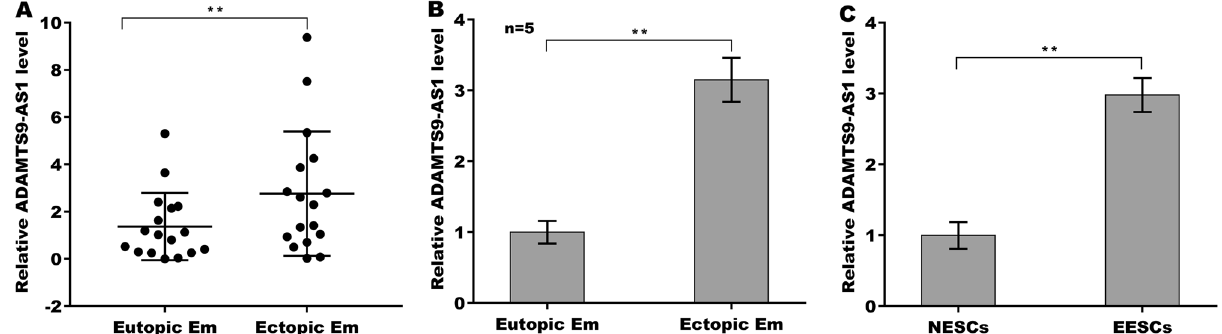
Figure 1. ADAMTS9-AS1 expression was increased in ecEM tissues. ( A ) qPCR analysis of ADAMTS9-AS1 in paired ecEM and euEM tissues (n = 17) in women with EMs. ( B ) A murine model of EMs was established, and the expression level of ADAMTS9-AS1 was assessed using qPCR analysis in ecEM and euEM tissues (n = 5). ( C ) Primary EESCs and NESCs were isolated from ecEM and euEM tissues of EMs mice, respectively, and then the ADAMTS9-AS1 level was assessed using qPCR analysis (n = 5). ** p <